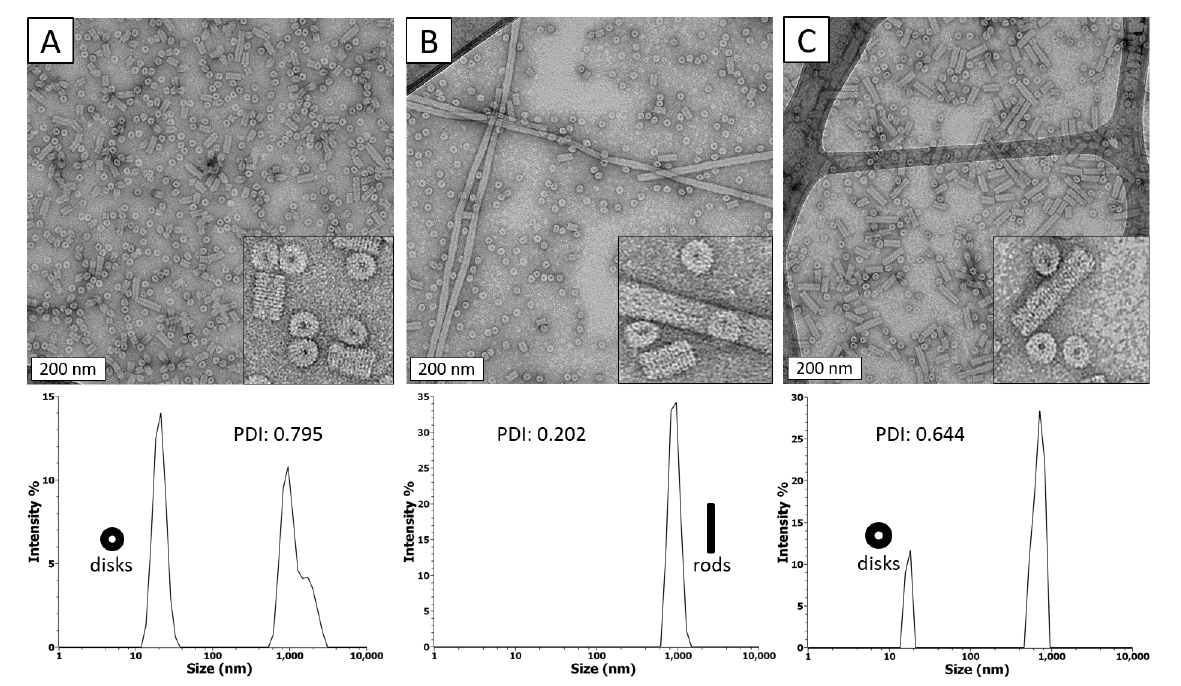
Figure 2: Comparison of TEM images (top) and DLS data (bottom) for TMV-cp assembled under different pH and ethanol concentrations. (A) pH 6.8, no additive; (B) pH 5.5, no additive; (C) pH 5.5, 3.5 mol % ethanol. A lower PDI (polydispersity index) indicates more